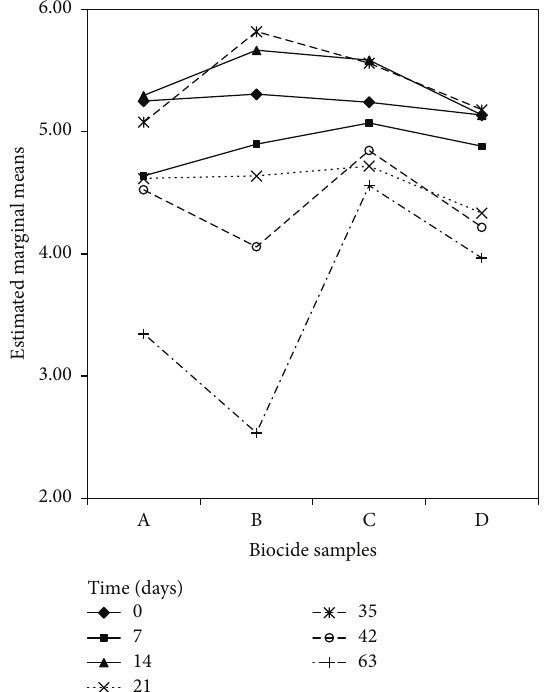
Figure 7: Profile plot of interaction between sample and time in the assessment of sanitizer biocide sample under factorial ANOVA